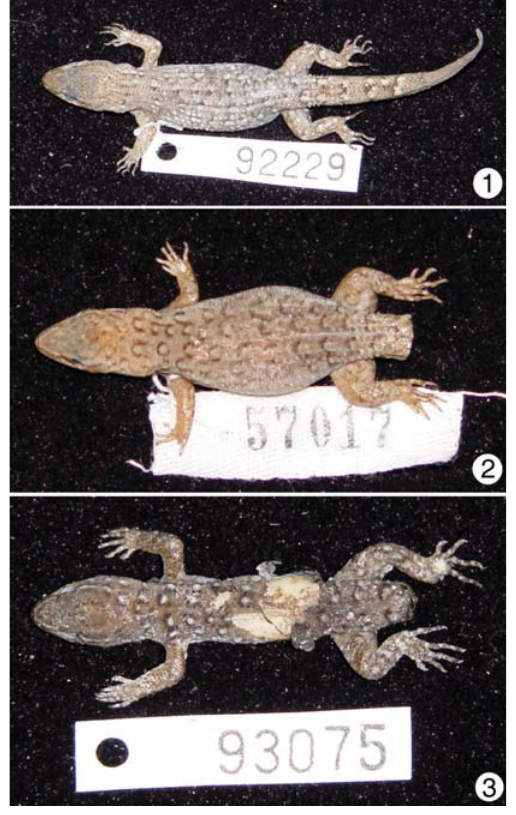
Fig. 1 – Gymnodactylus geckoides, MZUSP 92229, Salvador, BA. Fig. 2 – Gymnodactylus carvalhoi , sp.n., MZUSP 57017,